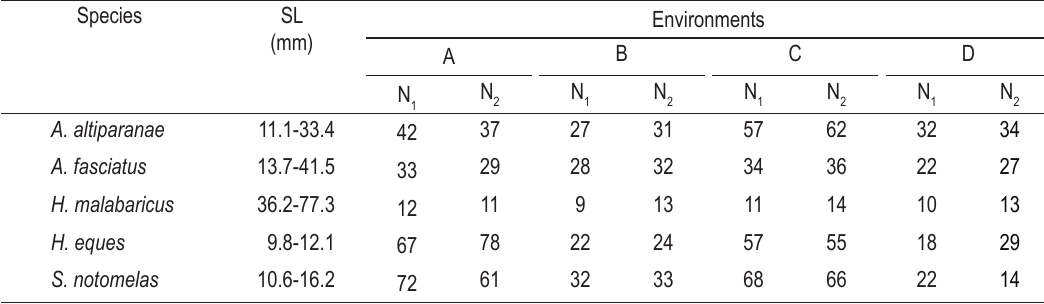
Table 2. Abundant and frequent species studied in the habitats: a) Gavião Peixoto Reservoir, b) Jacaré-Guaçu River,